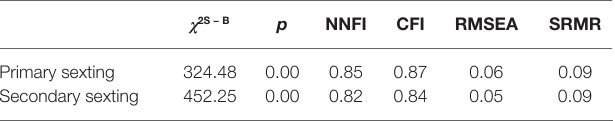
TABLE 2 | Fit indexes of the models to emotional impact including the three impact factors: Active, Depressed, and Annoyed.